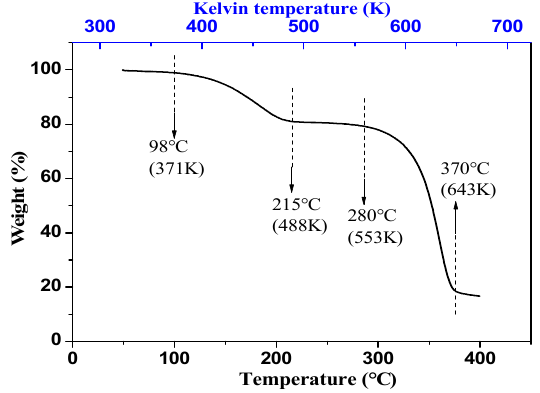
Figure 3. Thermal gravimetric analysis results of insulating paper.